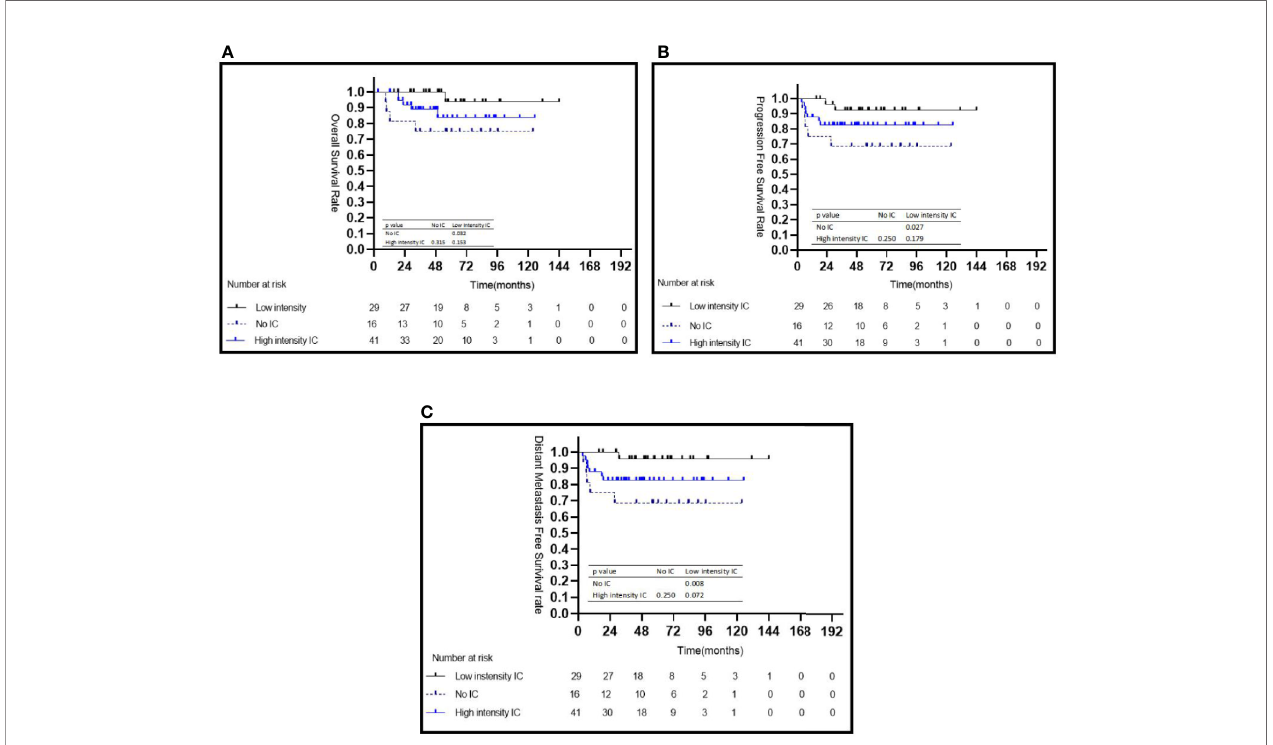
FIGURE 3 | Kaplan – Meier survival curves for the subgroup of 86 patients with NPC in the high-risk group strati fi ed by intensity of induction chemotherapy (A – C) . IC, induction